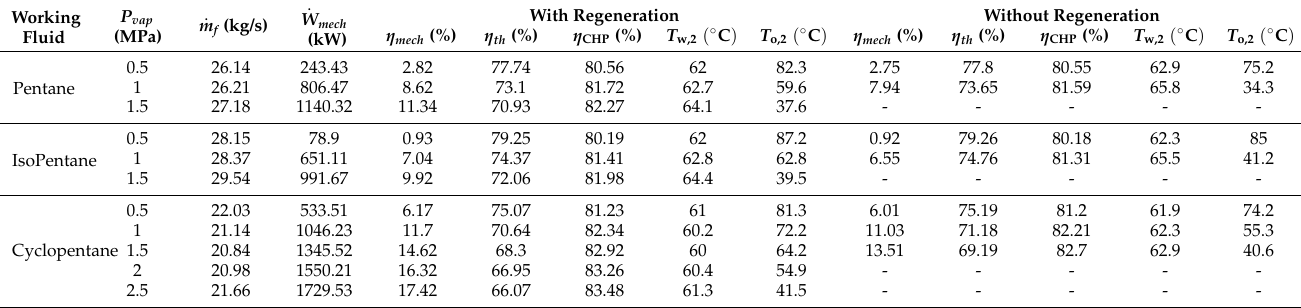
Table 5. Comparative presentation of the results for the hydrocarbons assumed in the present